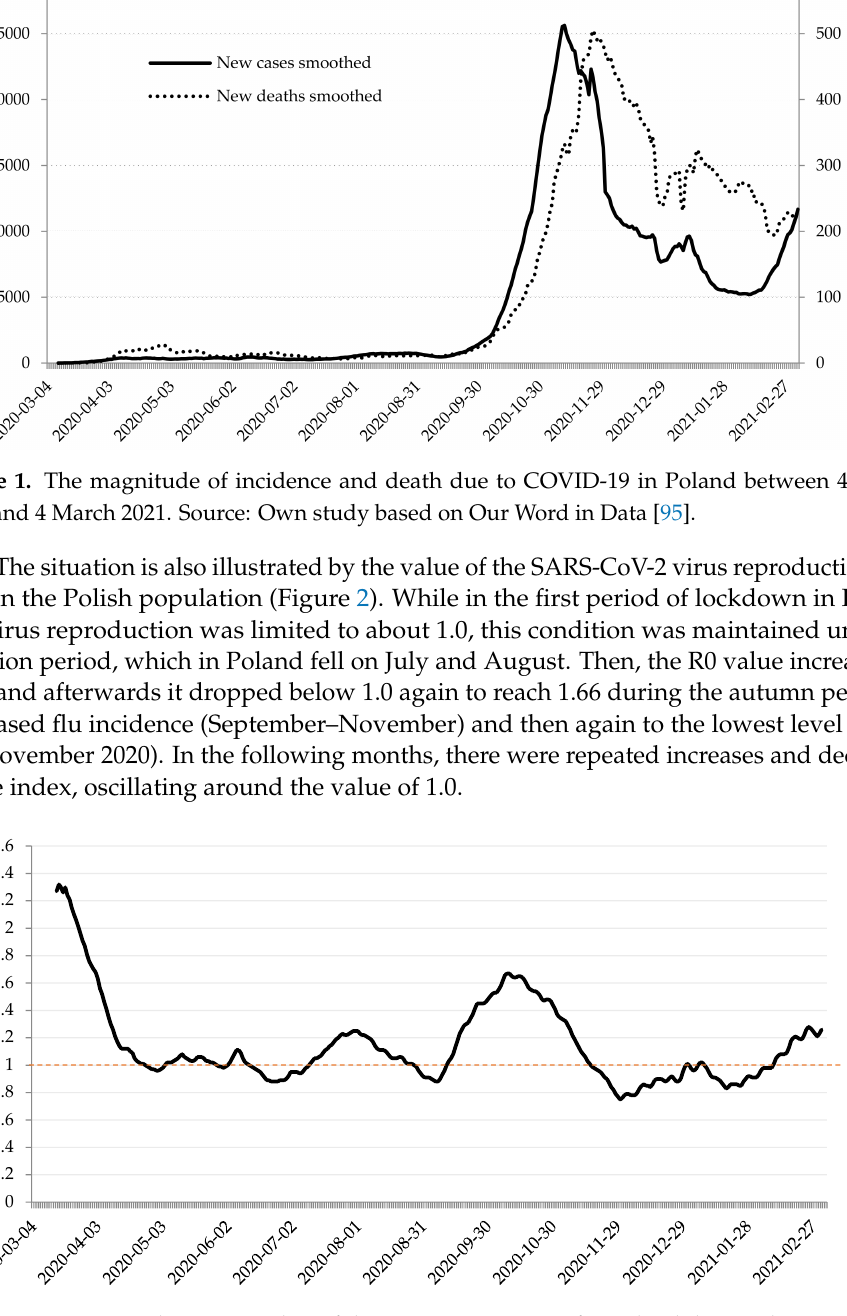
Figure 2. Basic reproduction number of the SARS-CoV-2 virus for Poland during the period from 4 March 2020 to 4 March 2021. Source: Own study based on Our Word in Data [95].